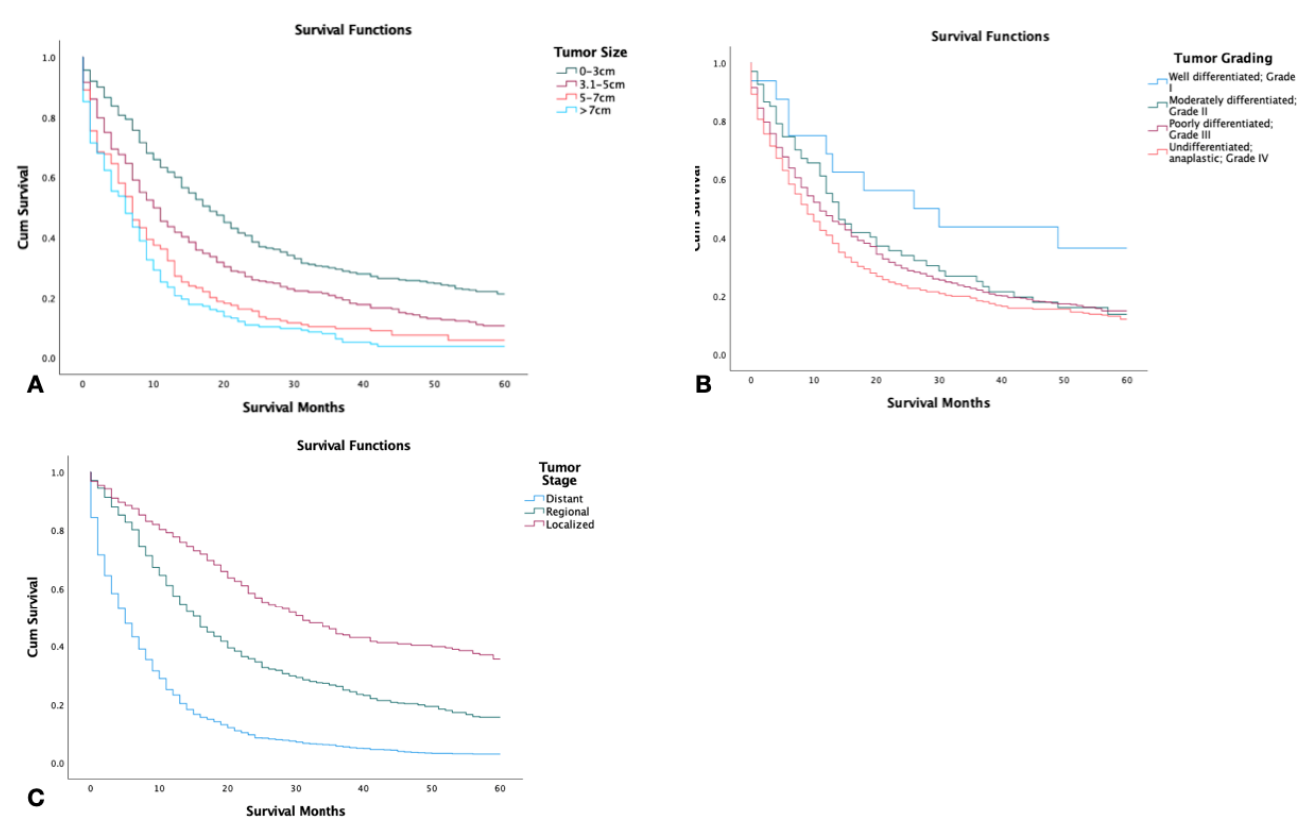
Figure 2. Kaplan–Meier survival graphs of 2126 patients with combined small-cell lung cancer from the surveillance epidemiology and end result (SEER) database by ( A ) tumor size, ( B ) tumor grade, ( C ) tumor stage. Log rank (Mantel – Cox) analysis ( χ 2 ) performed on each independent variable ( p < 0.001).